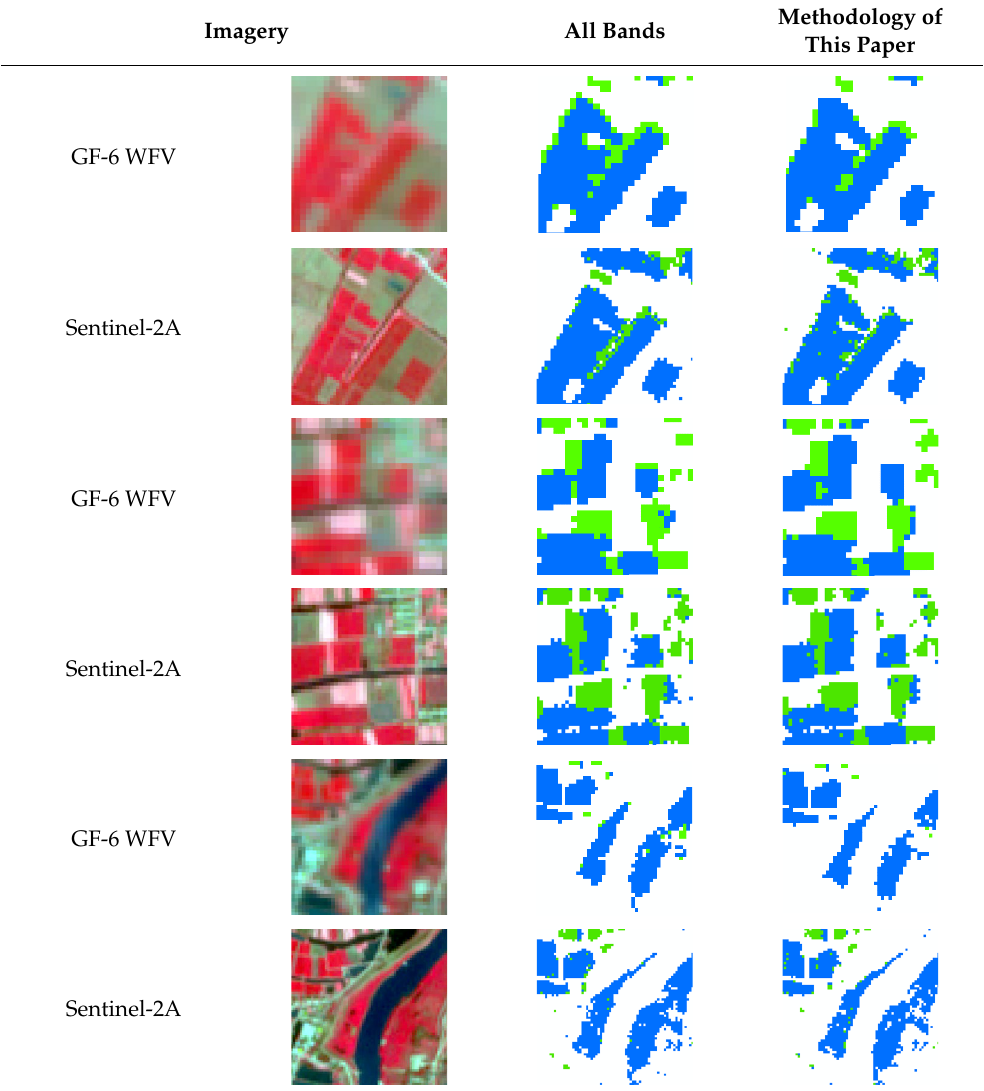
Table 8. Detailed comparison of GF-6 WFV and Sentinel-2A band sensitivities. Imagery